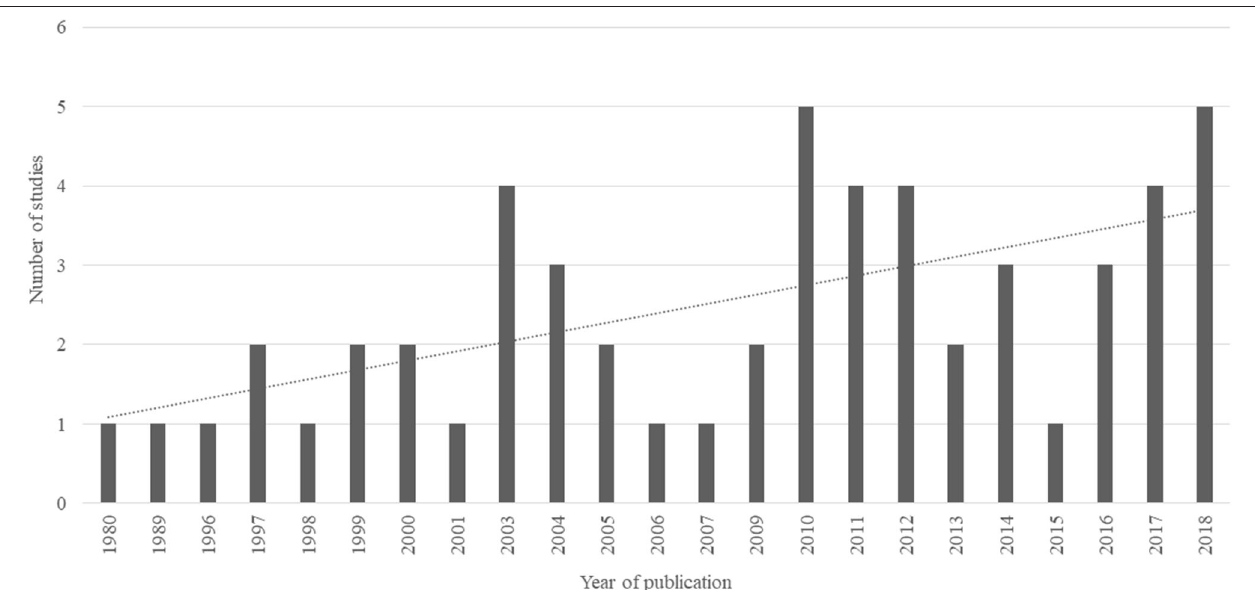
FIGURE 2 | Temporal distribution of reviewed normative studies using common objects across years